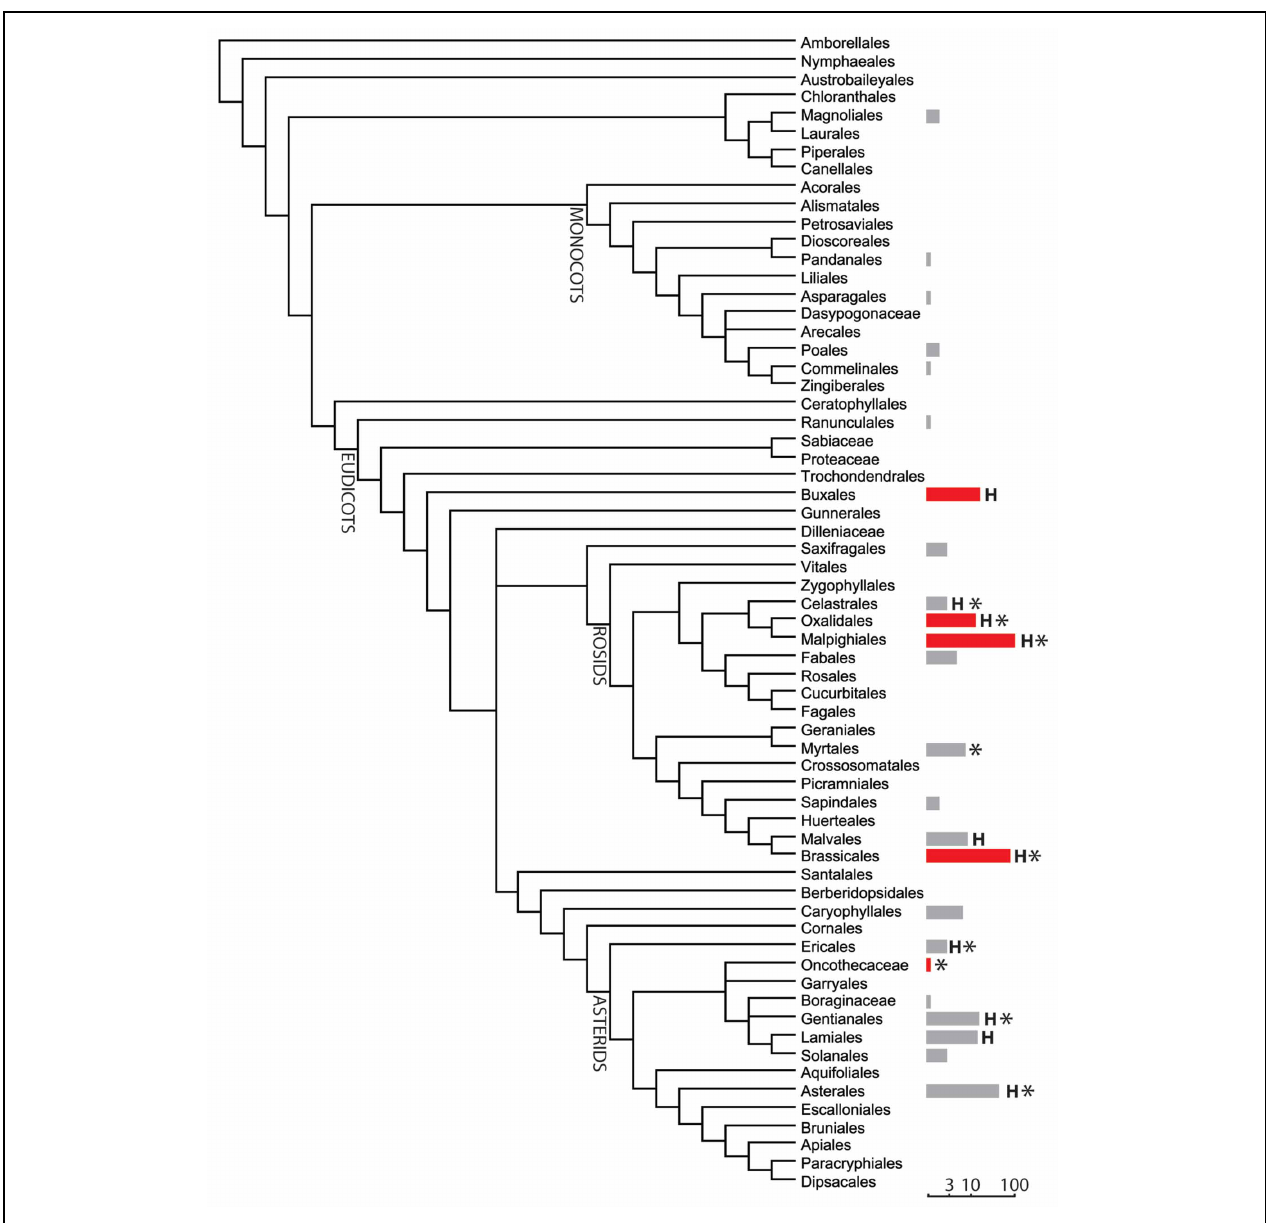
FIGURE 1 | Phylogenetic distribution of nickel hyperaccumulators using APG III classification. The number of Ni hyperaccumulator in each order is presented as a bar (logarithmic scale). The red bar indicates that the observed number of hyperaccumulators significantly exceed the theoretical